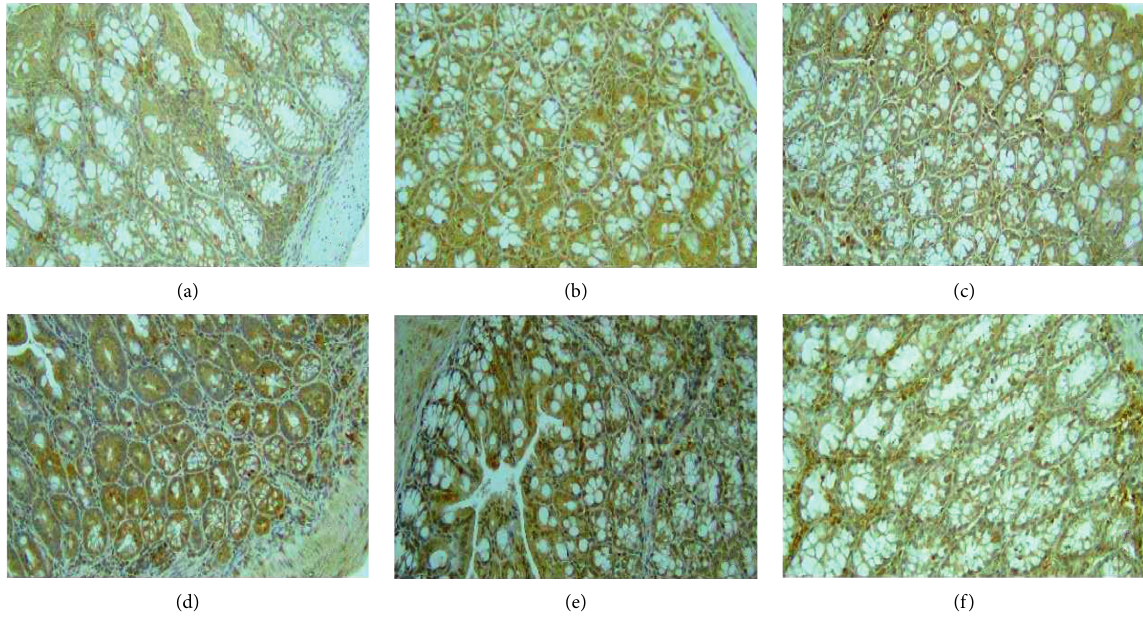
Figure 3: Observation of IHC staining for caspase-3 expression in mice crypt cells. Magnification: × 400. (a) DSS group, (b) normal group, (c) dose 1 (pomegranate peel extract, 240mg/kg/day), (d) dose 2 (pomegranate peel extract, 480mg/kg/day), (e) aspirin (43 mg/kg/day), and (f) ellagic acid